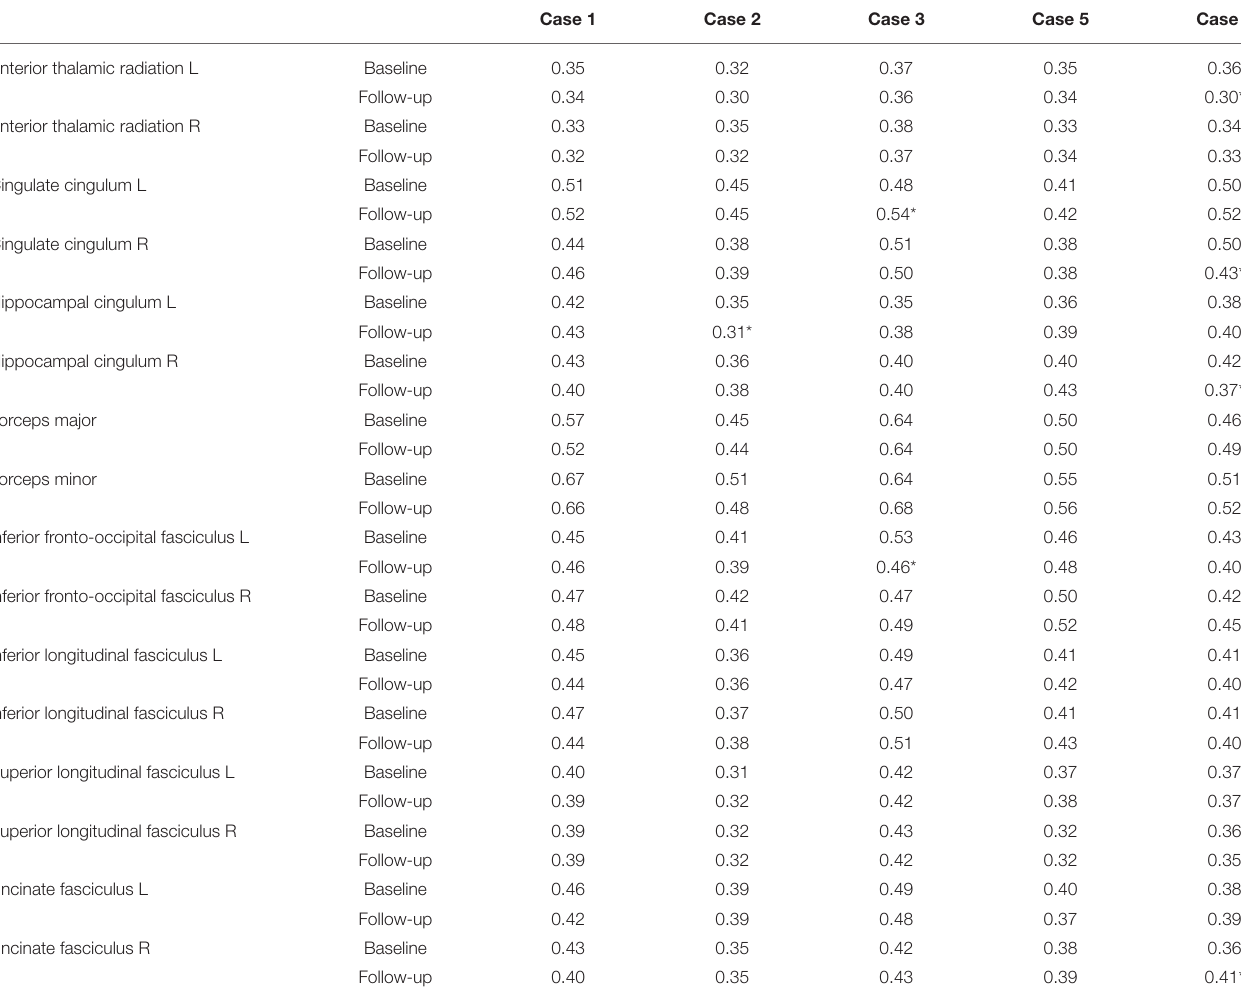
TABLE 6 | White matter (WM) tract fractional anisotropy for phenocopy frontotemporal dementia (phFTD) cases at baseline and